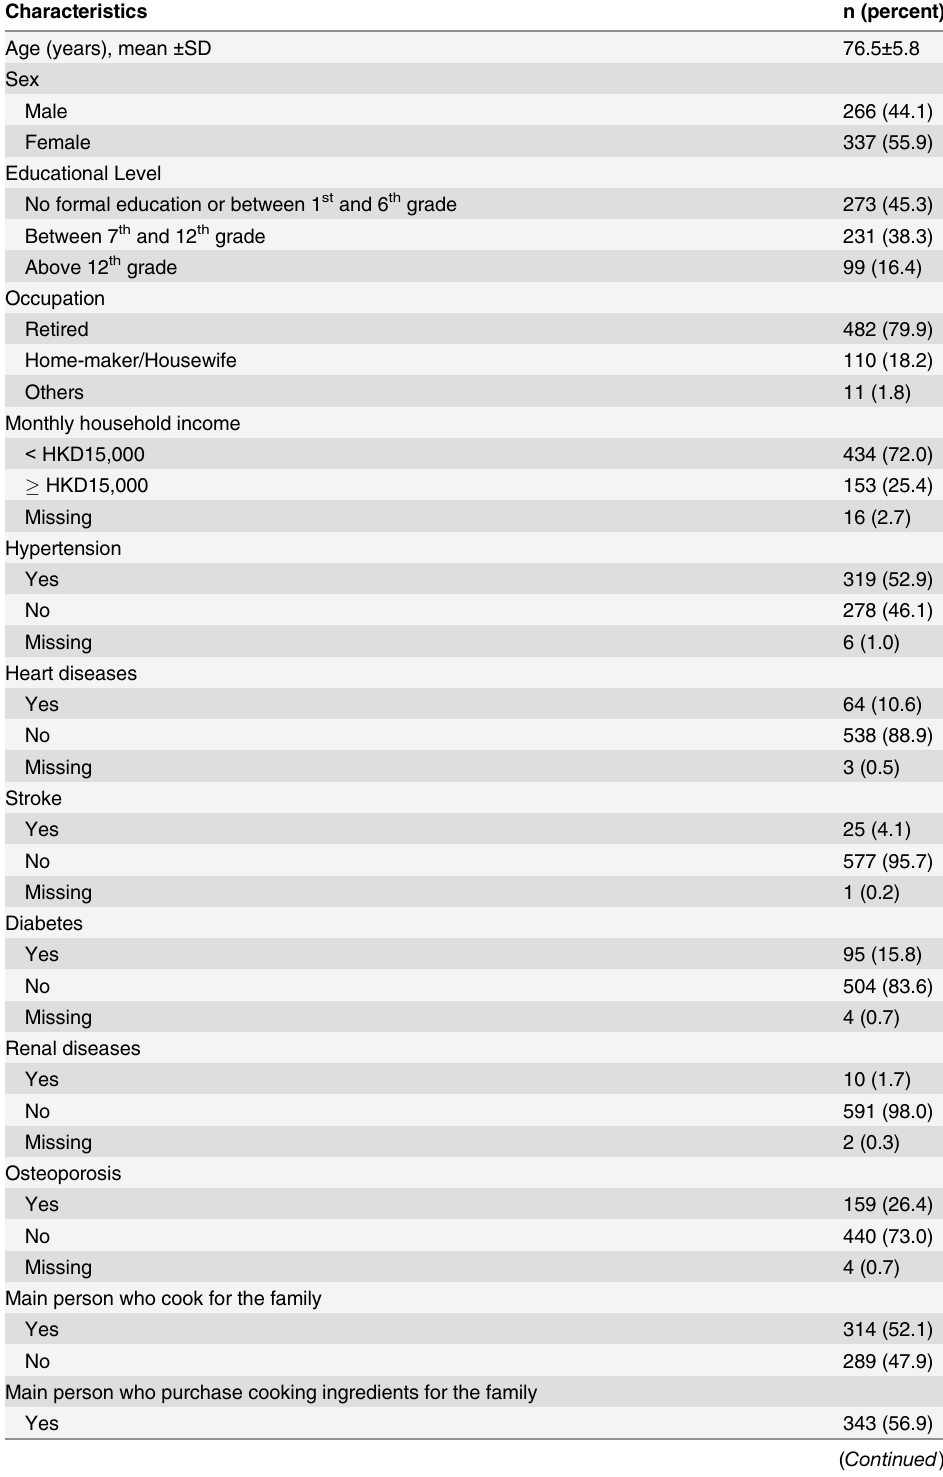
Table 1. Characteristics of the respondents (n =